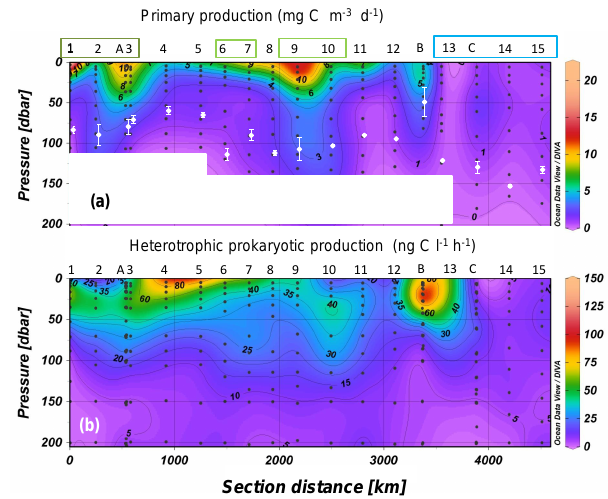
Figure 2. Distribution of primary production (a) and heterotrophic prokaryotic production (b) along the OUTPACE cruise transect; WMA (dark green), EMA (light green) and WGY (blue) stations are noted by colored rectangles. Interpolation between sampling points in contour plots was made with the Ocean Data View software (VG gridding algorithm, Schlitzer, 2004). In order to be homogeneous for the whole transect, for sites LDA, LDB and LDC the data plot- ted for PP were from a single profile, that of PP deck , while for BP we plotted all profiles. The white dots in (a) correspond to the av- erage ± SD of the dcm depth at each station. The white rectangles mask abnormal extrapolation due to the absence of PP